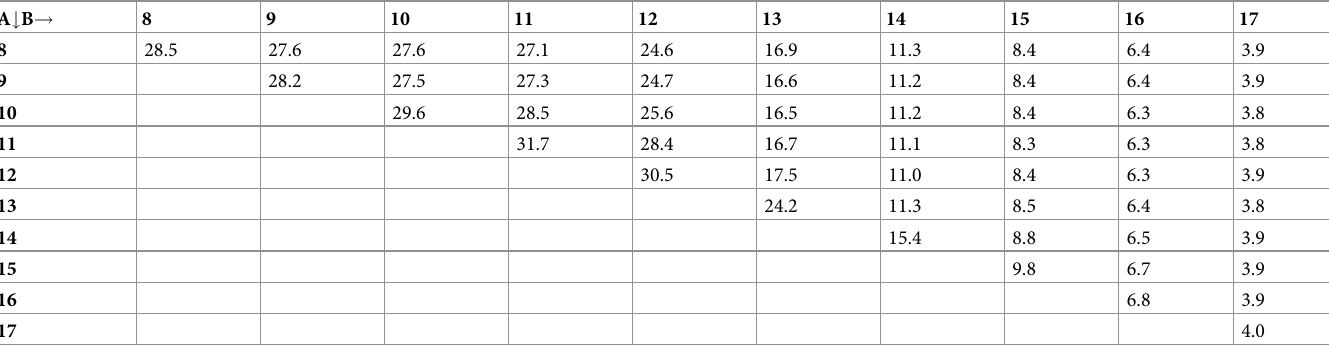
Table 2. Average error (in mm) for forecasting the mature height for girls using the height values beginning at age A and ending at age B. A # B